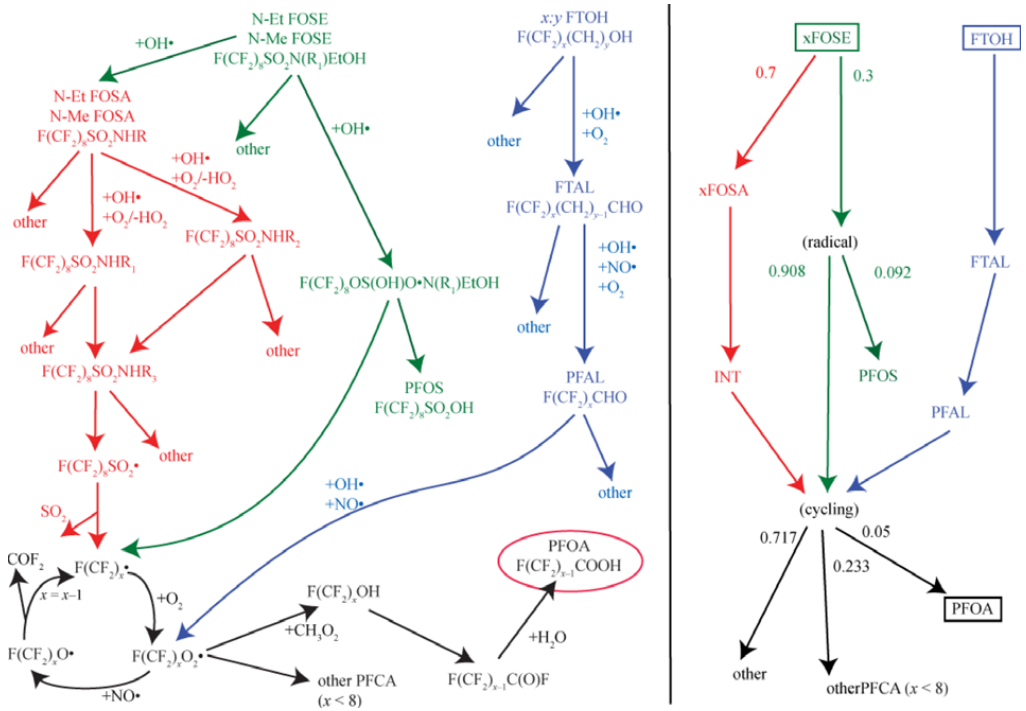
Fig. 4. Reaction scheme of PFOA precursors in air. Left: summarized information from laboratory measure- ments [34,35]. Right: simplified scheme implemented in the CliMoChem model; numbers indicated assumed reaction yields. Red: degradation pathways of fluorosulfonamides; green: degradation pathways of fluorosulfon- amido ethanols; blue: degradation pathways of fluorotelomer alcohols; black: conversion of perfluoroalkyl radi- cals, F(CF 2 ) x , to perfluorocarboxylic acids of di ff erent chain lengths. Reprinted with permission from Schenker et al. [37]. Copyright 2008 American Chemical